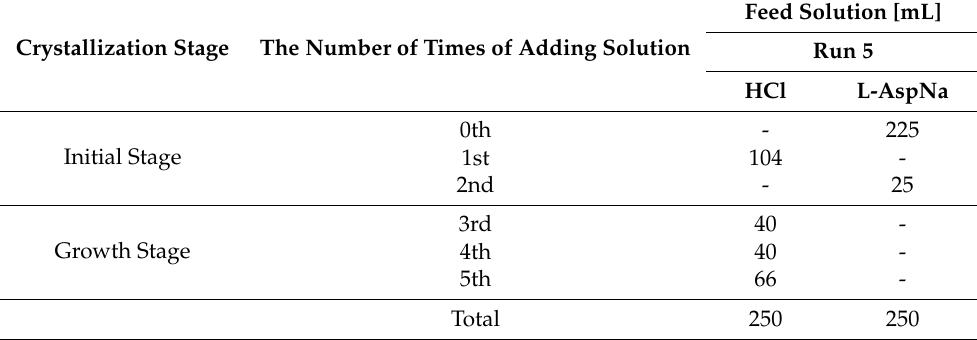
Table 3. The detailed addition methods in Run 5.